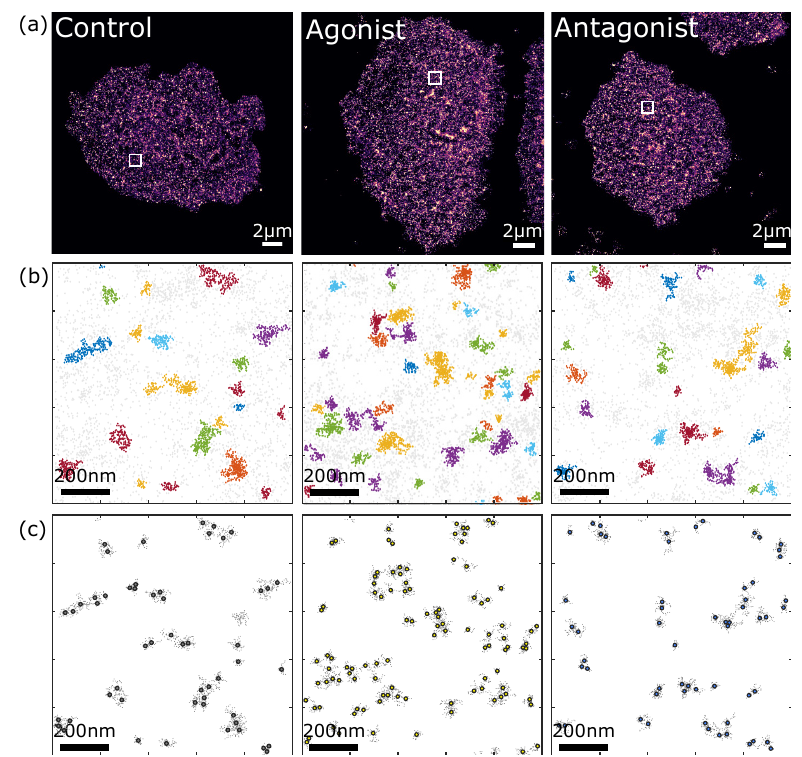
Figure 2. Automated data processing procedure to localize and quantify P2Y 2 receptor nanoscale distribution. ( a ) Representative rendered DNA-PAINT images of P2Y 2 proteins in AsPC-1 cells under control, agonist, and antagonist treatments. White box indicates ROI for subsequent cluster analysis displayed in ( b ). ( b ) DBSCAN cluster analysis output for ROIs indicated in ( a ) under control, agonist, and antagonist treatments. Non-clustered points are shown in grey. ( c ) Quantitative protein maps of the ROIs indicated in ( a , b ) displaying P2Y 2 receptors (larger coloured points) in each cluster overlayed on clustered DNA-PAINT single-molecule localizations. (Left to right) control conditions indicated in grey, agonist conditions in yellow and antagonist conditions in blue.